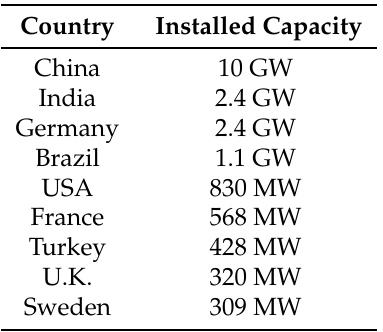
Table 1. The top 10 new installed capacity by country in 2016